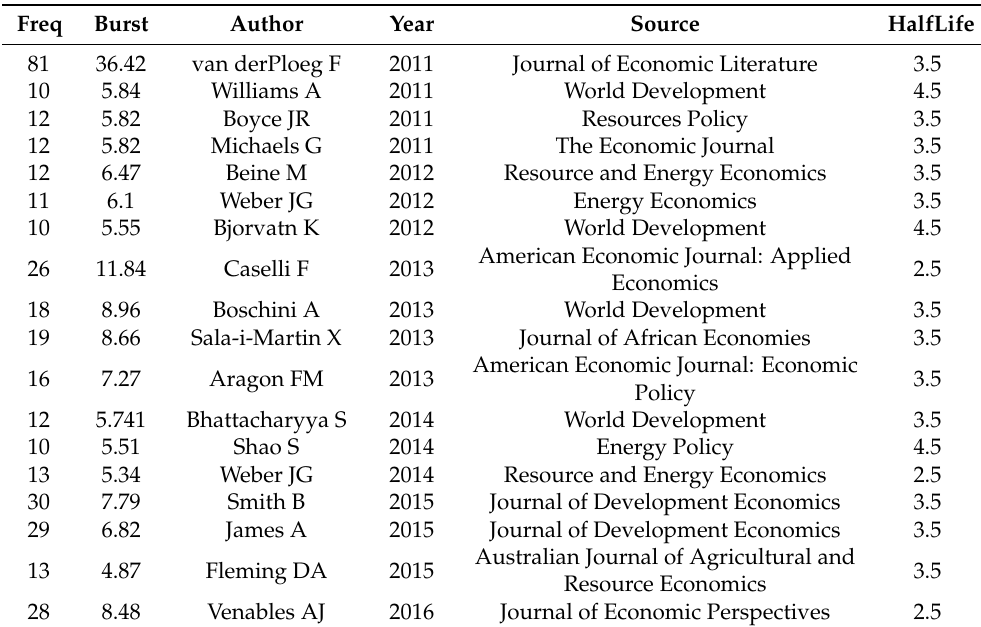
Table 6. Exploration and summary of Cluster